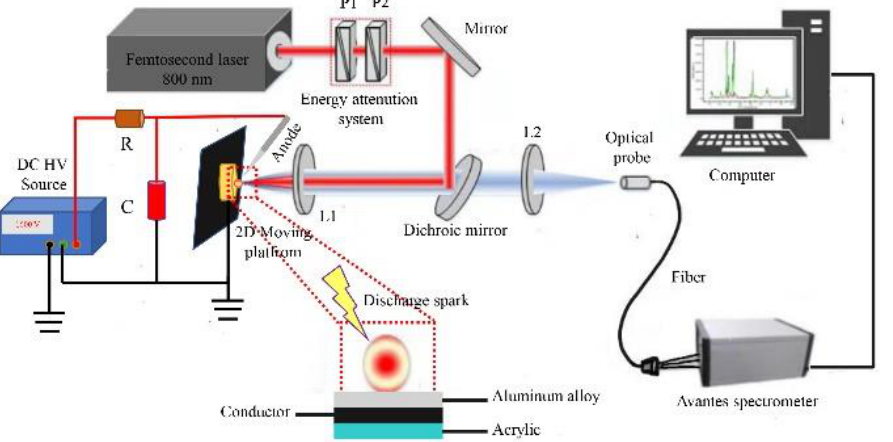
Figure 1. Schematic diagram of fs LA-SIBS. P1 and P2: Glan–Taylor polarizer; L1 and L2: quartz lens; R: resistor; C: capacitor.